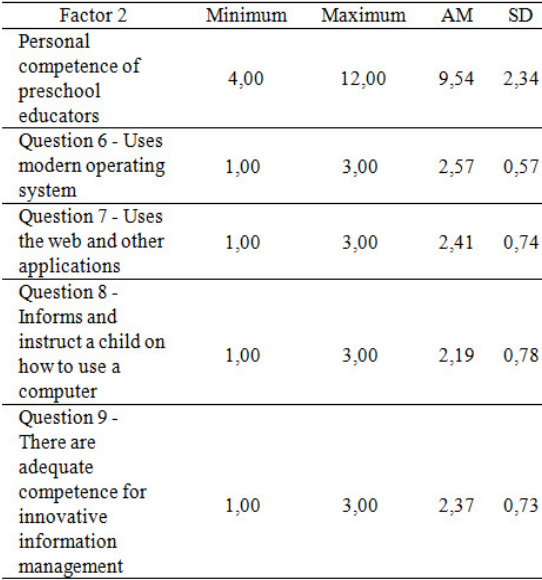
Table 6. Expressiveness ofattitude